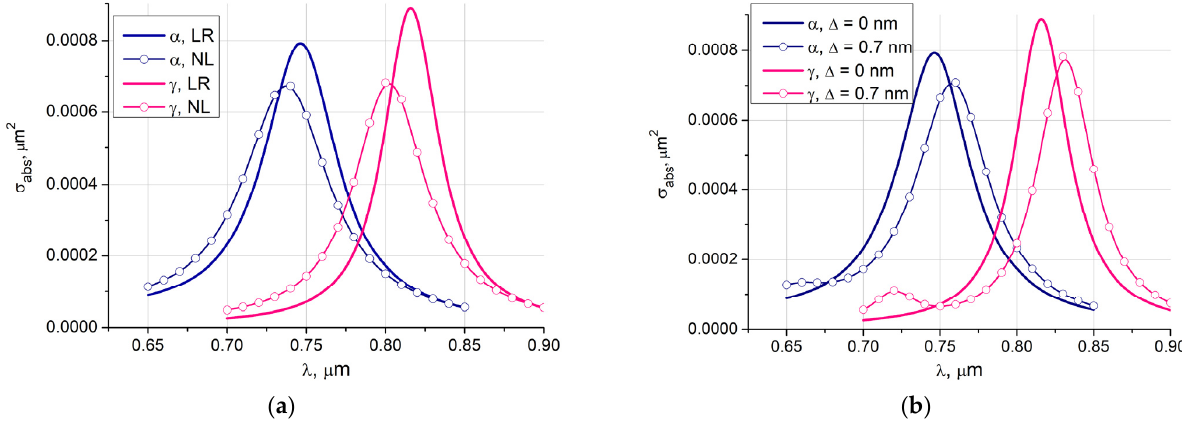
Figure 3. Absorption cross-sections of two particles with different magnetic core materials Fe 3 O 4 ( α ) and Fe 2 O 3 ( γ ), core diameter D = 16 nm, gold shell thickness d = 2 nm: ( a ) local response (LR) and non-local response (NL) results; ( b ) influence of the shifted by Δ nm core for the local response. The results are averaged by the angles of incidence and polarizations.